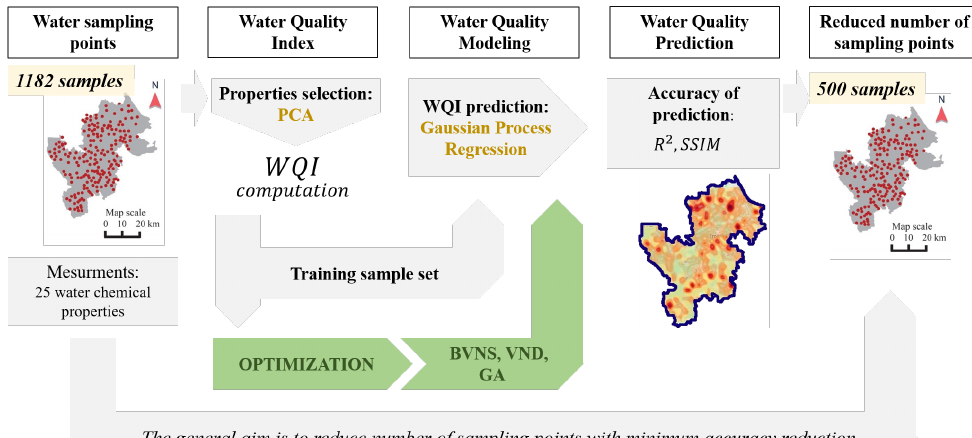
Figure 2. Outlines of the